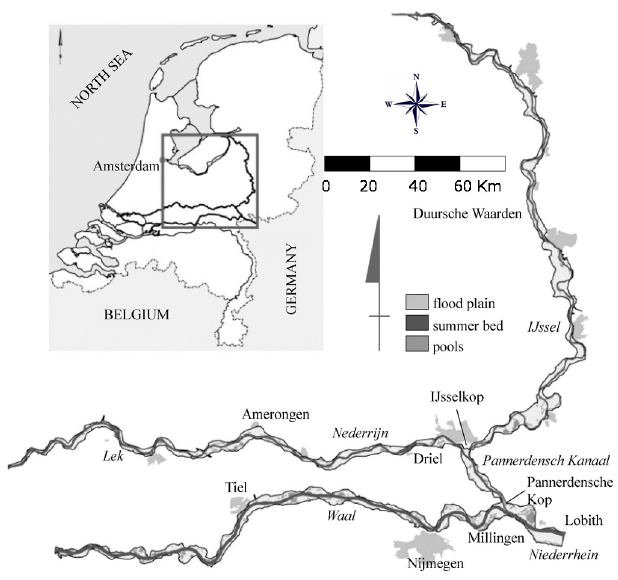
Figure 1. The Dutch Rhine branches (copyright RWS).